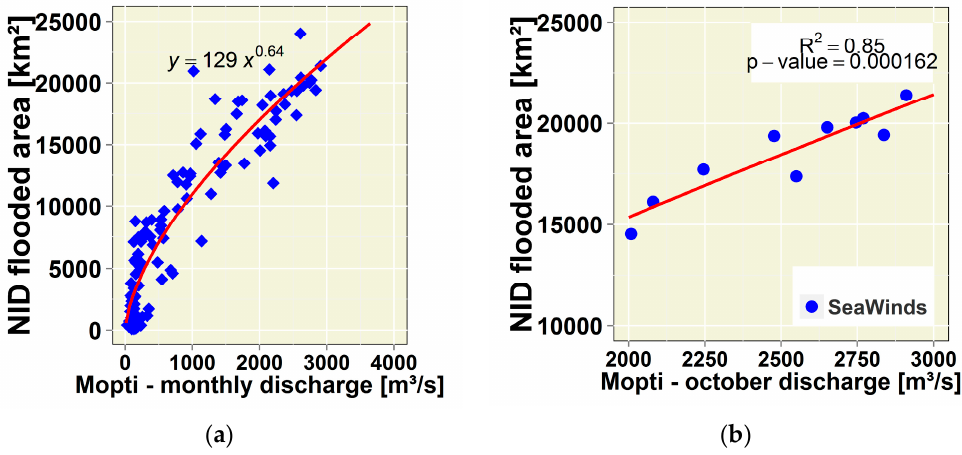
Figure 4. ( a ) Non-linear regression relationship between inflow discharge and remote sensing area estimates (SeaWinds data), relative to the gauge of Mopti (Monthly discharge m 3 /s); ( b ) correlation between Mopti October mean maximum monthly flows and SeaWinds monthly peak flood extent estimates.